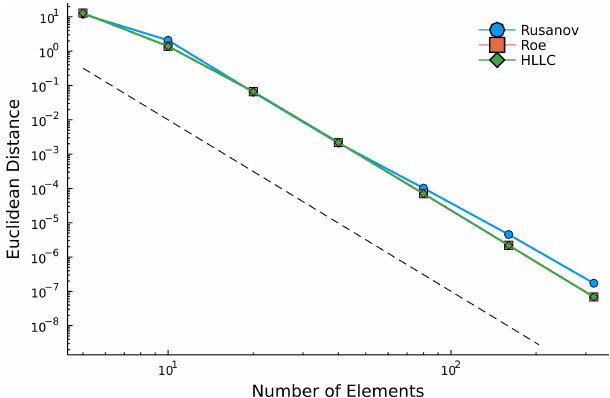
Figure 1. Euclidean distance between initial and final solution vectors of the prognostic variables generated using Rusanov (oc- tagons), Roe (squares), and Harten–Lax–van Leer contact (HLLC) numerical fluxes. Final solutions are evaluated at t end = 10 − 4 s based on a translational velocity of 150ms − 1 . For each numeri- cal flux method, we consider N e = [ 5 , 10 , 20 , 40 , 80 , 160 , 320 ] el- ements with fourth-order polynomials. The dashed line represents N − 5 e